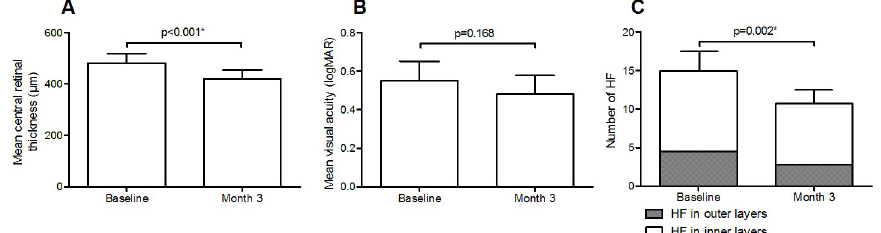
Fig 2. Differences between before and after treatment with anti-VEGF. Mean changes in central retinal thickness (A), visual acuity (B) and number of hyperreflective foci (C) at baseline and after 3 injections with anti-VEGF. The bars represent mean ± 95% confidence interval. � P < 0.05.